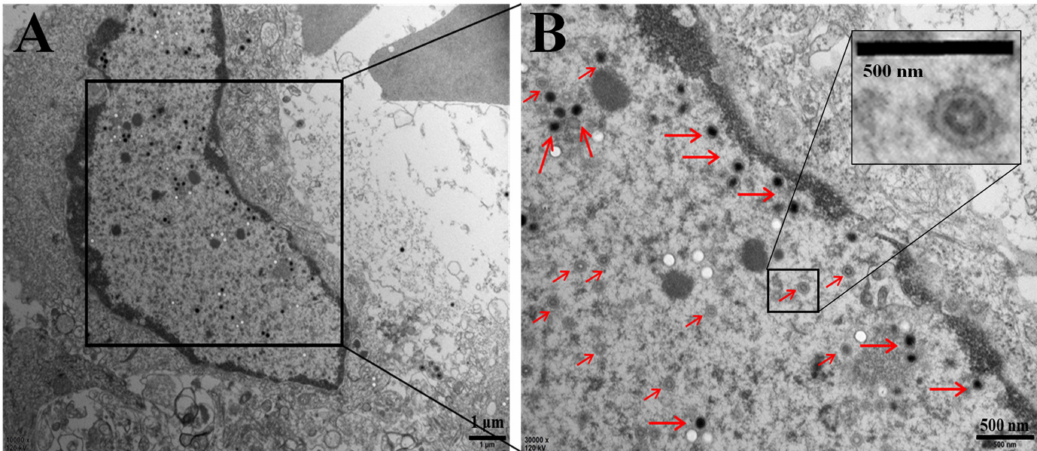
Figure 3. Electron micrograph showing mature virions (red arrow) in a naturally infected kidney cell of crucian carp.